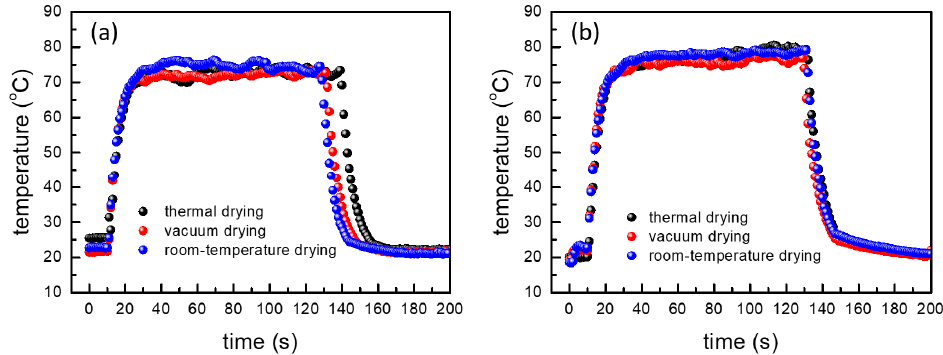
Figure 6. Heating characteristics of various heaters fabricated with ( a ) the AgNW-exposed and ( b ) the AgNW-embedded electrodes with various drying methods.